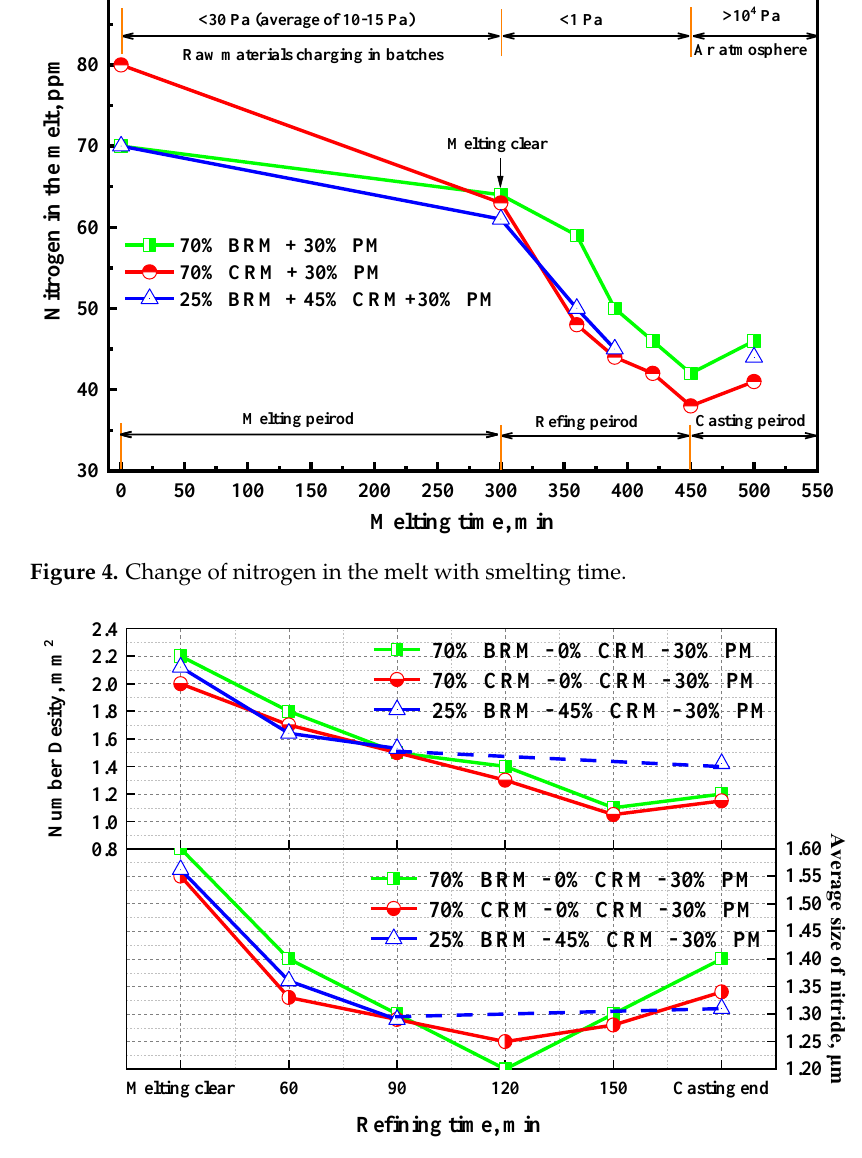
Figure 5. Change of quantity density and average size of nitride in the superalloy samples obtained. With the refining time, the quantity density of nitrides in different cases shows a similar trend, changing from the average 2.1 per mm 2 at the melting endpoint to 1.1 per mm 2 at the refining end to 1.3 per mm 2 at the casting end. The trend of the variation in the quantity density of nitrides is consistent with that of the nitrogen content, i.e., as the nitrogen content continues to decrease, the quantity density of nitrides also decreases correspondingly. By comparison of the three cases, Case-C with 25% BRM plus 45% CRM plus 30%PM has the largest quantity density of nitride in the casting end, reaching 1.4 per mm 2 . The quantity density of nitrides decreases with the refining time, but the average size changes little, and remains in a range of 1 to 1.5 µ m. The single returned material cases (Case-A and Case-B) can obtain lower total nitrogen than the mixed returned material case